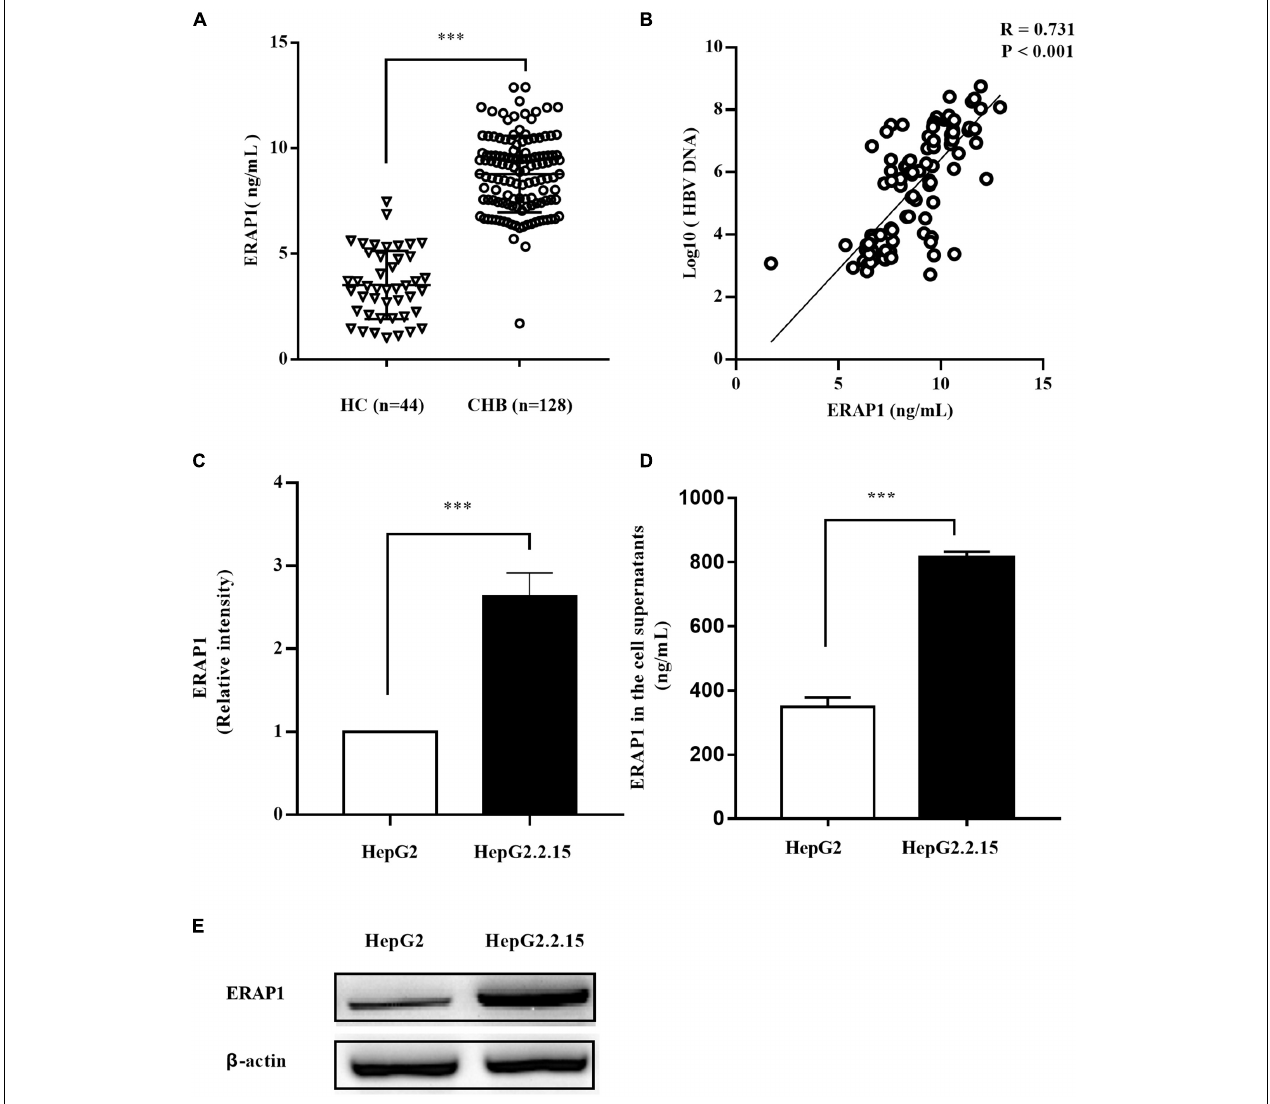
FIGURE 1 | HBV infection promotes ERAP1 expression and secretion. (A) the peripheral level of ERAP1 in patients with CHB ( n = 128) and HC ( n = 44) was detected by ELISA. (B) Pearson’s correlation analysis between sera ERAP1 and HBV DNA of patients with CHB. (C,E) ERAP1 expression and quantitative analysis in HepG2.2.15 cells and the germline HepG2 cells. (D) The amounts of ERAP1 in supernatants ofHepG2.2.15 cells and the germline HepG2 cells. Data are presented as the mean ± SD of three independent experiments. CHB, chronic hepatitis B; HC, healthy control. * ** p <